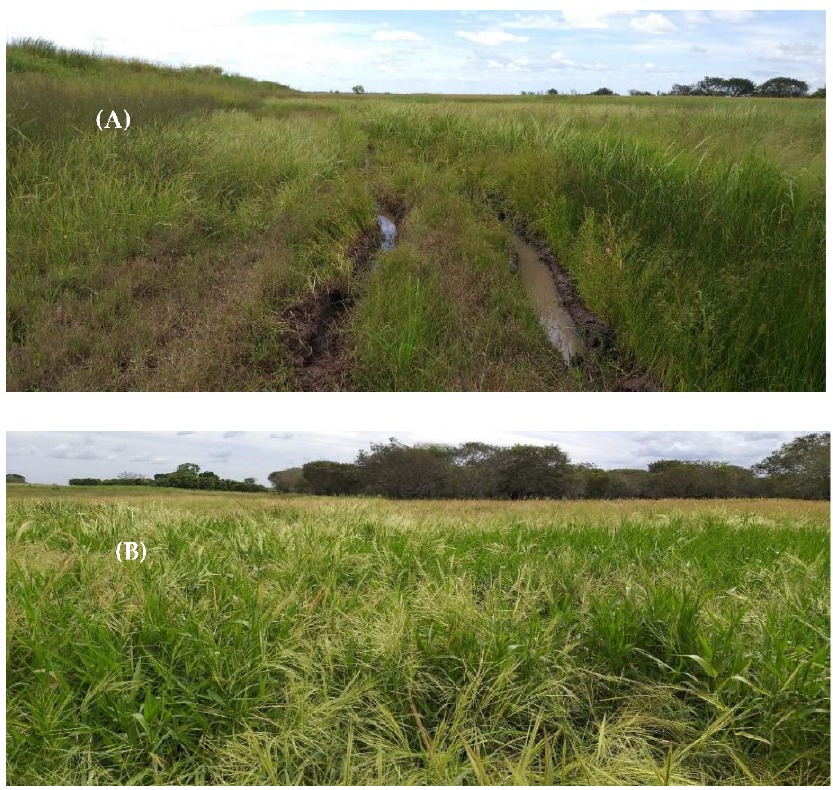
Figure 2. Australian wild Oryza populations growing in their natural habitat in northern Australia. ( A ) O. meridionalis and ( B ) O. rufipogon .